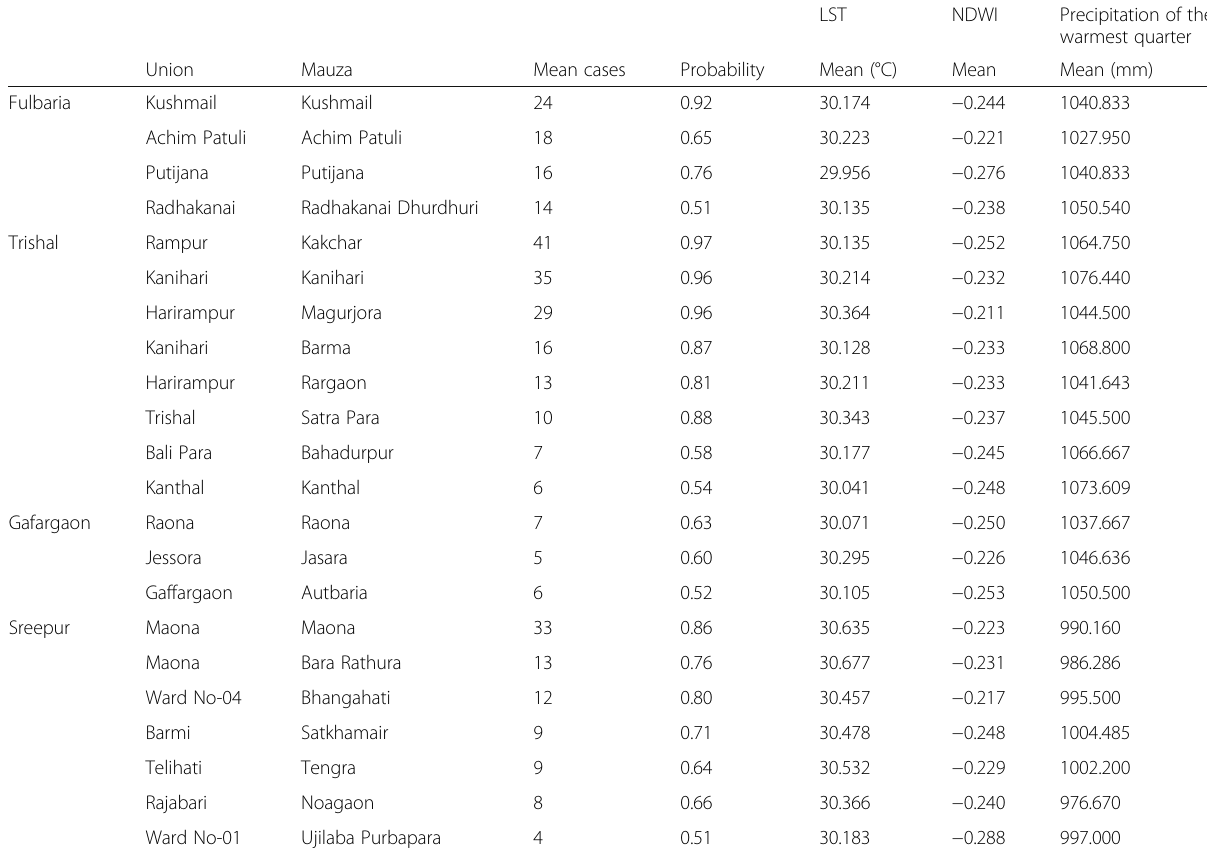
Table 4 Mauzas showing moderate to high probabilities of the VL cases, caused by P. argentipes with corresponding mean value of environmental